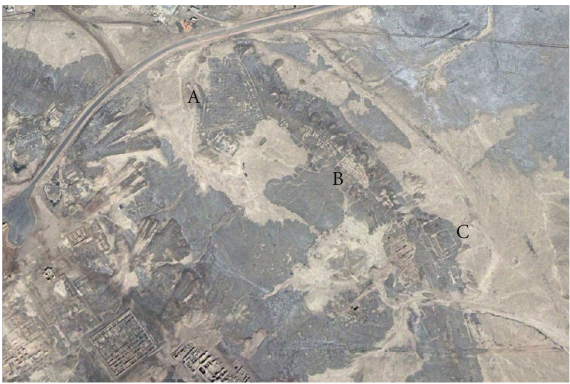
Figure 10: Traces and remains of the Palace of Ennigaldi-Nanna (A), of few houses built against the city walls (B), and of the Kassite Fort (C) in a pan-sharpened QuickBird-2 image of February 2002 (colour composite RGB bands 3-2-1).